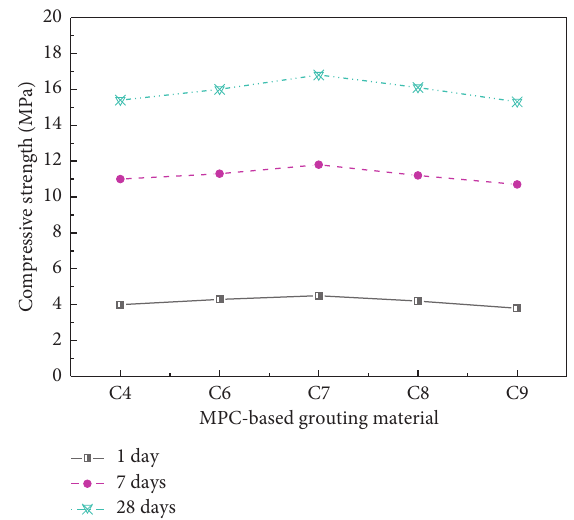
Figure 7: The compressive strength of the hardened sample with different additions of